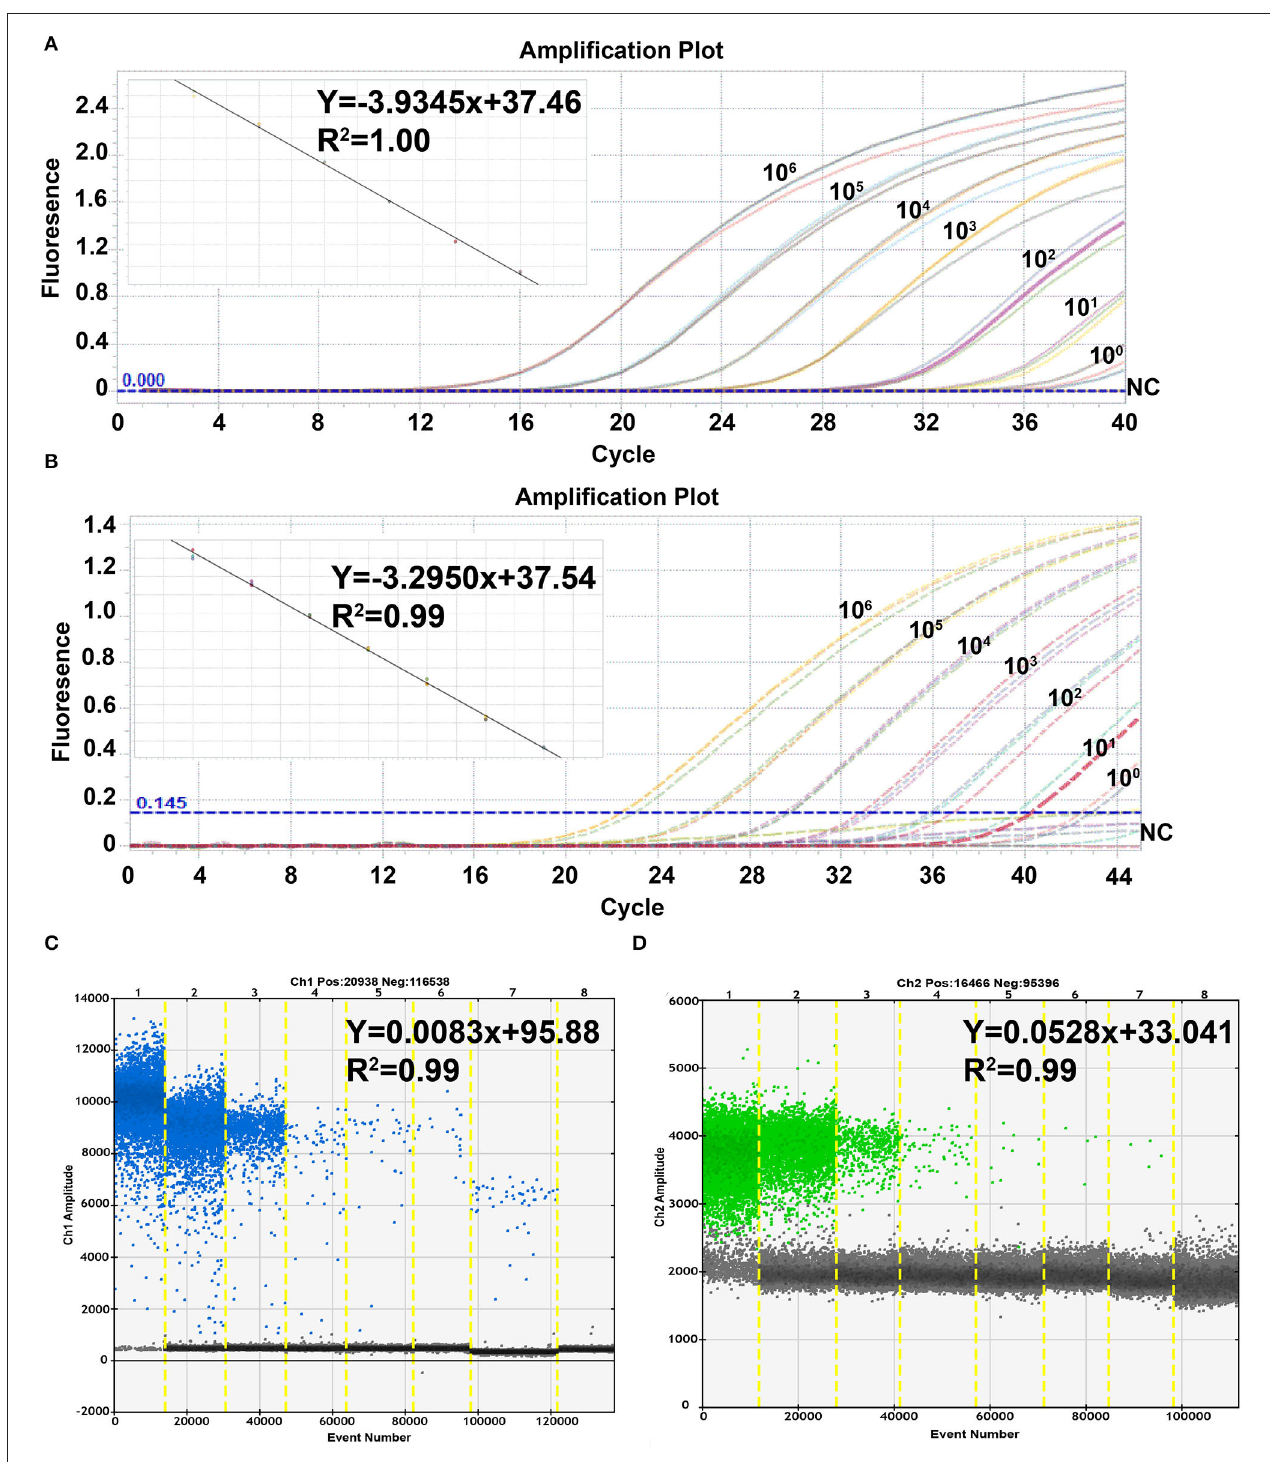
FIGURE 2 | Sensitivity of the duplex real-time PCR and the ddPCR assay. The duplex real-time PCR assay for pB646L (A) and pEP402R (B) was evaluated at concentrations of 10 6 -10 0 copies / µ l template and nuclease-free water as negative control (NC). The duplex ddPCR assay for pB646L (C) and pEP402R (D) was evaluated at the same concentration condition and the template plasmid concentrations gradient (lanes 1–8) was 10 6 , 10 5 , 10 4 , 10 3 , 10 2 , 10 1 and 10 0 copies / µ l, and